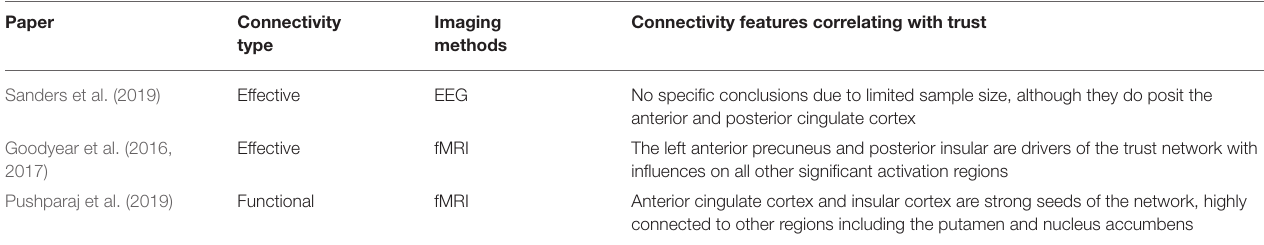
TABLE 5 | Summary of connectivity